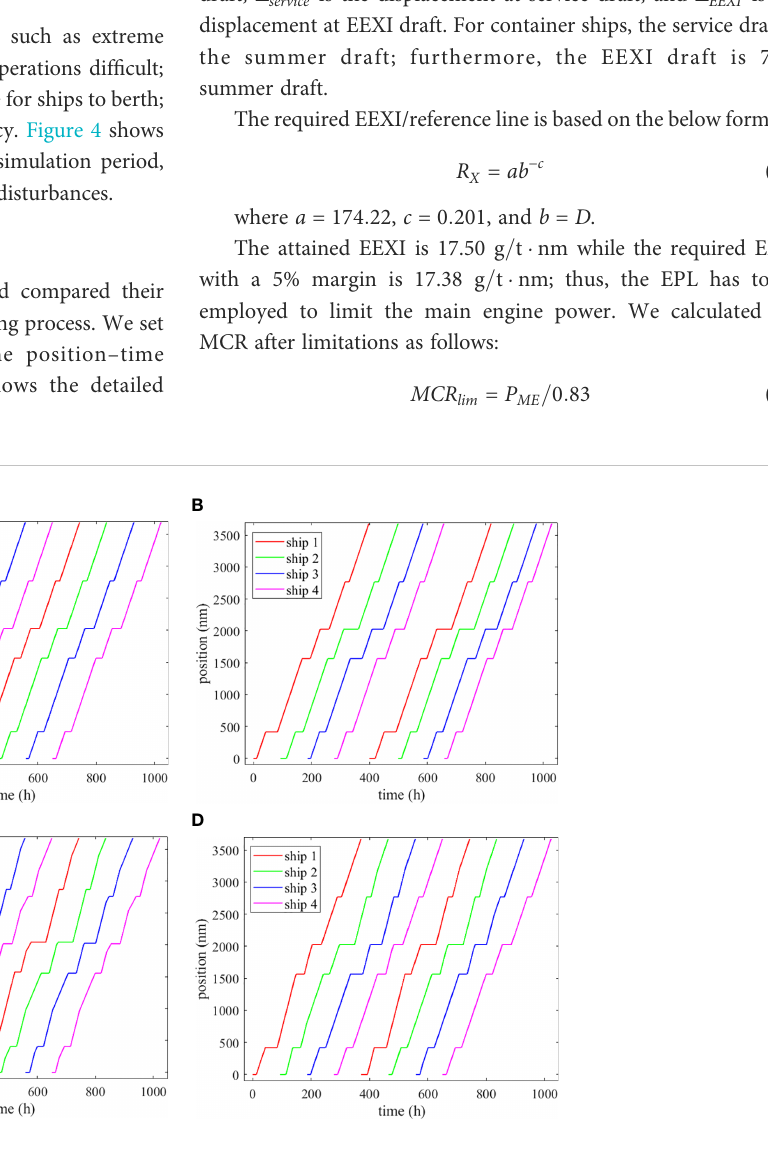
FIGURE 6 Power – speed